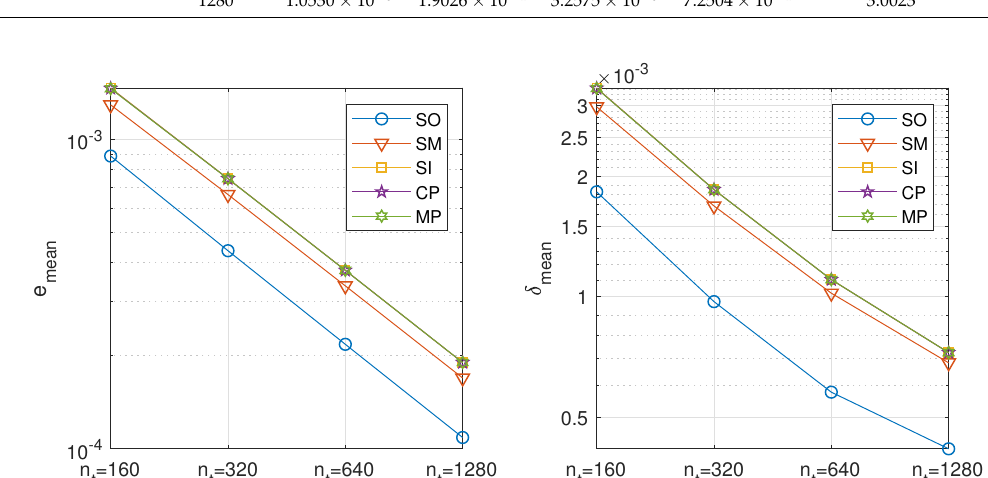
Figure 9. Mixed convection-diffusion and Burgers’ equation, directional decomposition. Precision of the proposed methods: sequential iterative SI, classical parallel CP, and modern parallel MP, compared with the classical ones: sequential operator SO and Strang–Marchuk SM, for different number of time